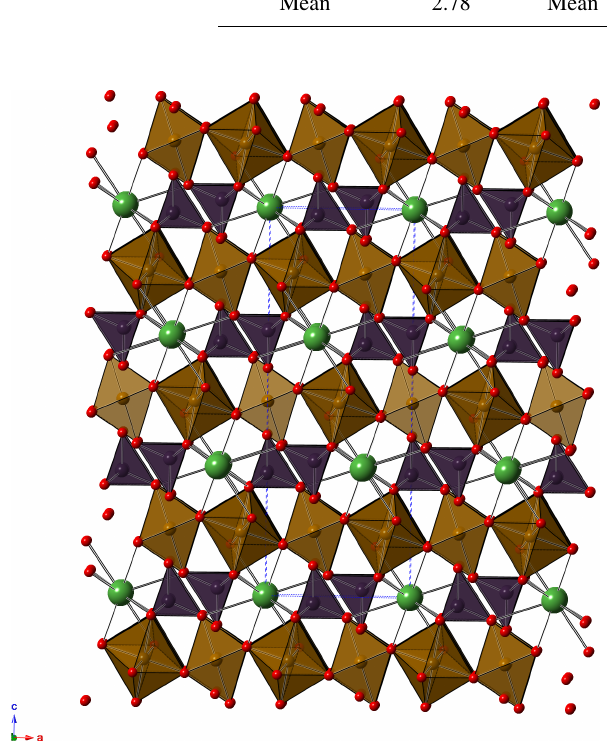
Figure 4. Crystal structure of graulichite-(La), as seen down b . Brown and violet polyhedra represent the B - and X -centered sites, whereas green and red circles are the A and O(1), O(2), and OH sites,